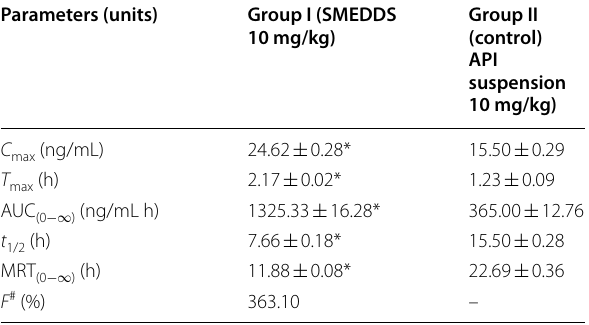
Table 5 Pharmacokinetic parameters after oral administration of vorinostat suspension (pure drug) and optimized vorinostat- loaded SMEDDS (F7)